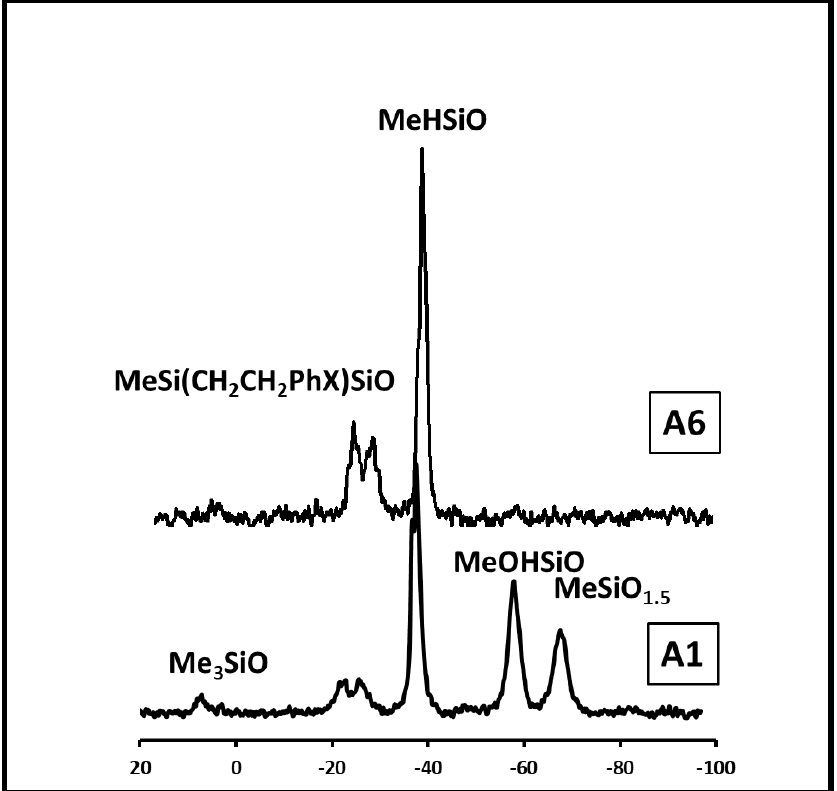
Figure 1. 29 Si MAS NMR spectra of the precursor polysiloxane microspheres obtained at different DVB/PHMS w / w ratio: A-1 = 0.17, A-6 = 0.97; X = CH 2 CH 2.